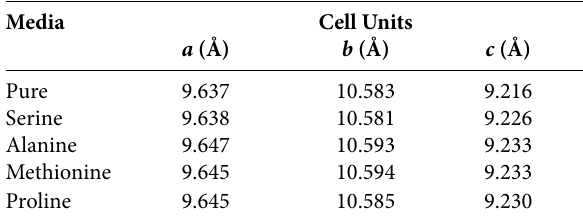
Table 1. The unit cell dimensions for crystals obtained in pure me- dia and media supplemented with various amino acids.